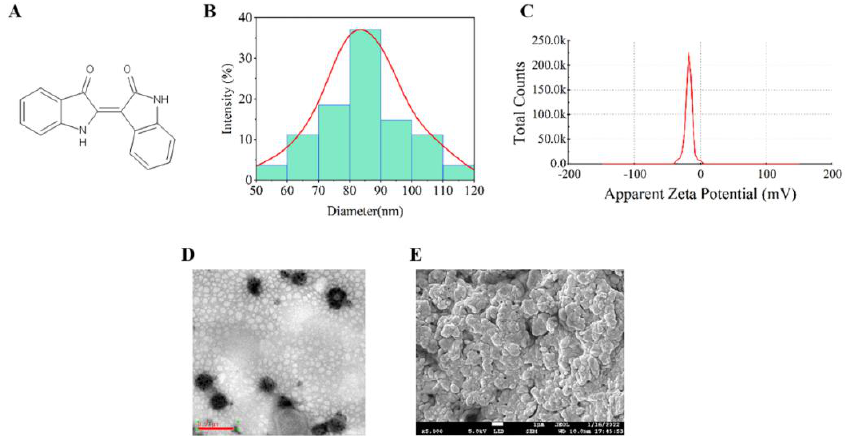
Figure 4. Physicochemical characterization of IR-loaded ME and IR-loaded ME-based hydrogel. ( A ) IR chemical structure. ( B ) Size distribution of the IR-loaded ME. ( C ) The zeta potential distribution of IR-loaded ME. ( D , E ) The electron micrographs of ME and ME in ME gel (Scale bar: 0.2 μm).